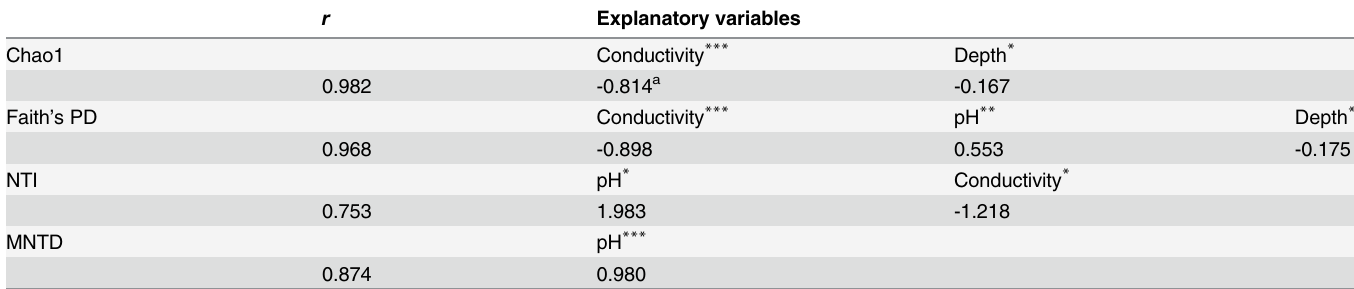
Table 1. Relationships between the bacterial diversity and potential explanatory variables that were modelled using step-wise multiple regressions. r Explanatory variables